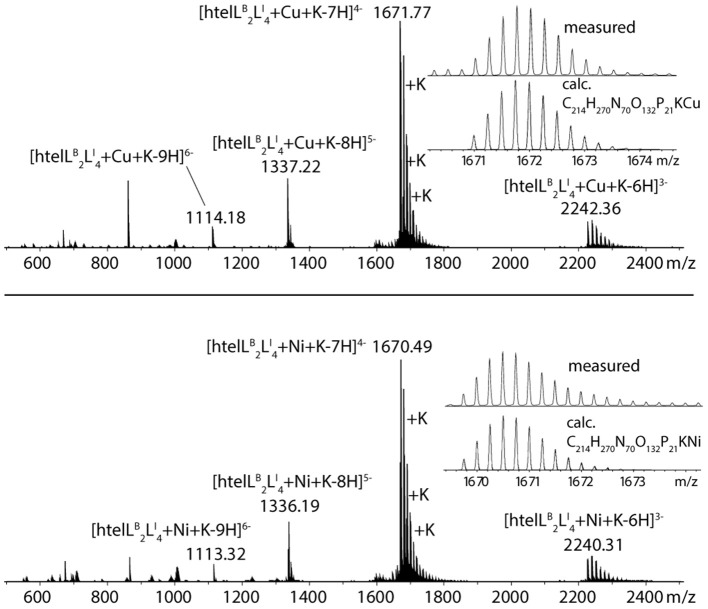
Native ESI-MS spectra of htelLB
2LI
4 in complex with CuII (top) and NiII (bottom).